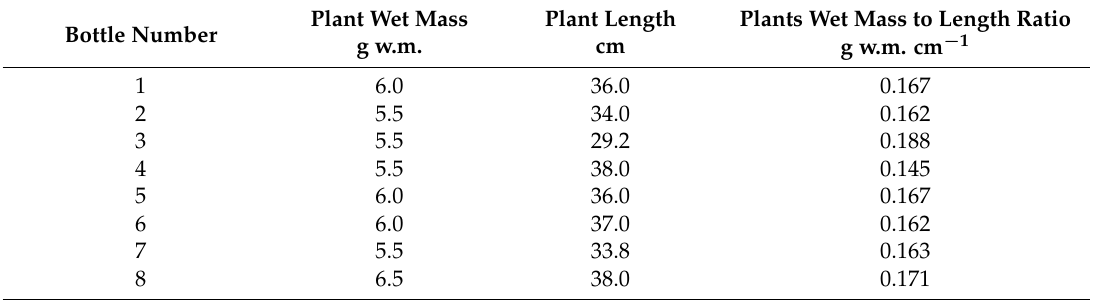
Table 1. The dimensional characteristic of used plants of E. densa : wet mass (g w.m.), length (cm), plants wet mass to length ratio (g w.m. cm − 1